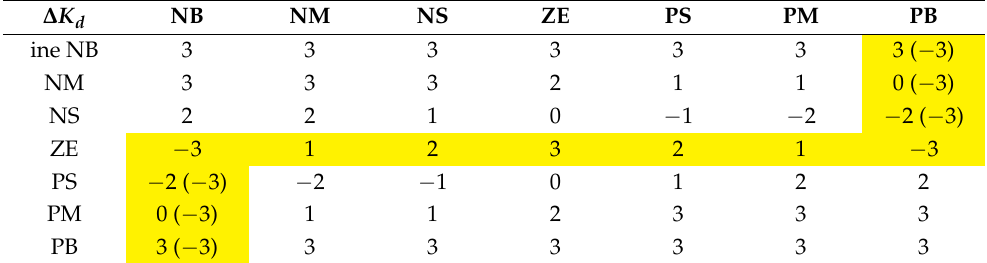
Table 4. Fuzzy rule base of ∆ K d (yellow background are the cells of sparse rule bases).